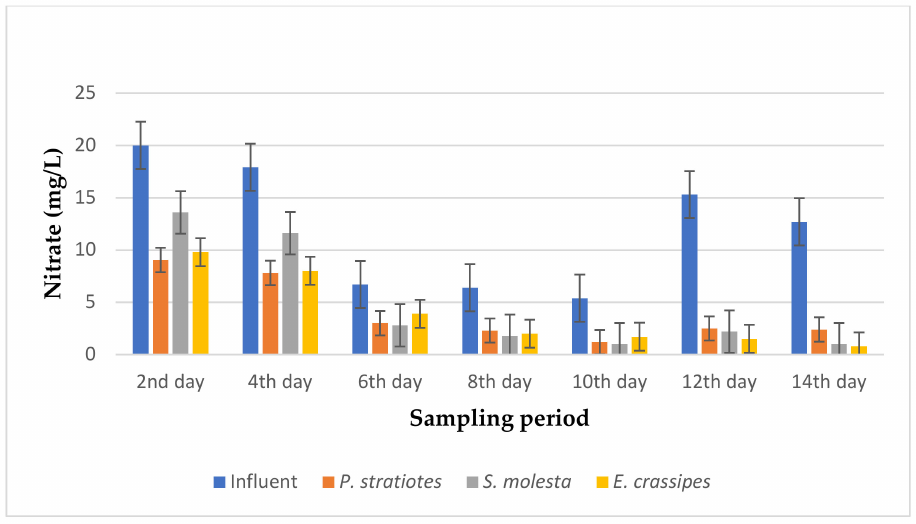
Figure 14. Bar plot of the average nitrate vs. the sampling period with a 24 h retention